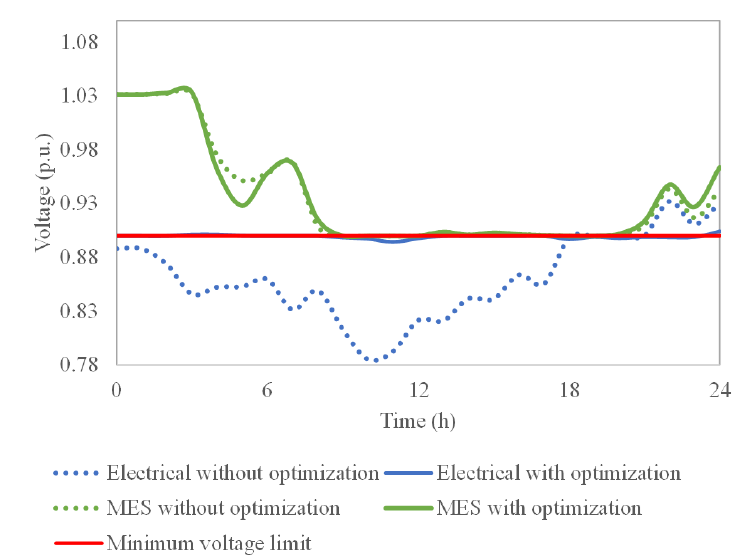
Figure 9. Voltages during the day at bus